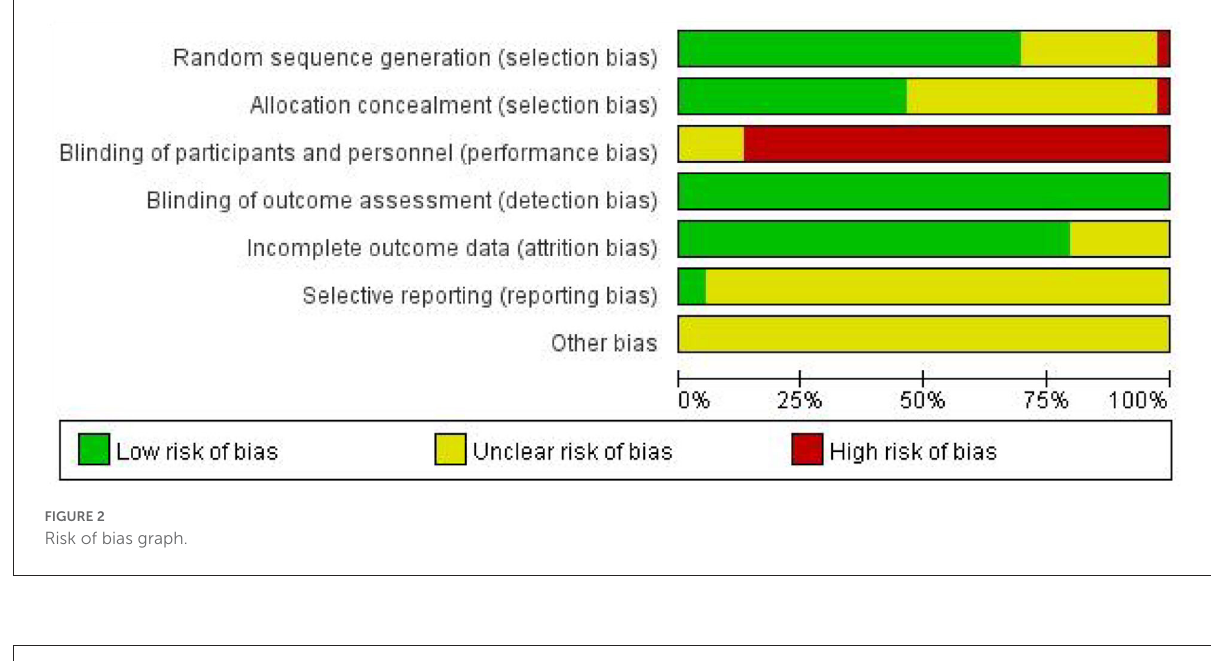
FIGURE2 Risk of bias graph.